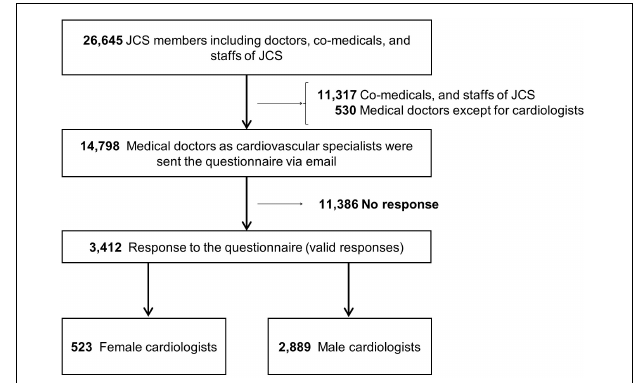
FIGURE 1 | Flowchart of response to the questionnaire. The JCS had 26,645 members such as doctors, co-medicals, and staffs of JCS. The 14,798 doctors in the cardiovascular field were registered until April 2021 in JCS (2021) and were sent the questionnaire via email at April 28, 2021. Data were obtained from 3,412 doctors. Of the 3,412 responses, 523 were from women and 2,889 from